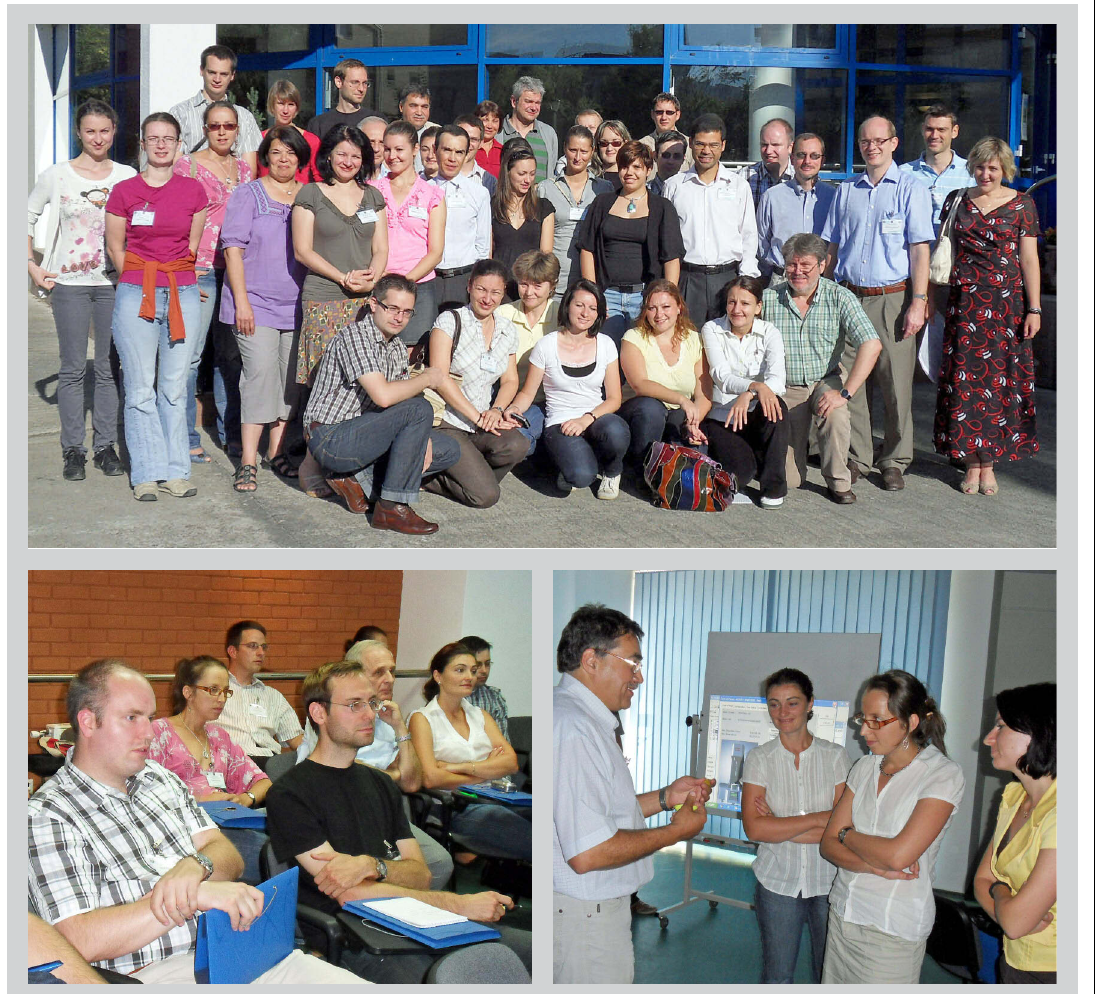
Figure 1 (above): The summer school was hosted by Babes-Bolyai Uni- versity, “Universitas” Hotel (Cluj Napoca). Figure 2 (left below): More than 30 participants assisted the presentations during the sessions of the summer school. Figure 3 (right below): The students attended the experiments performed by István Albert, the represen- tative person of PAAR- PHYSICA in